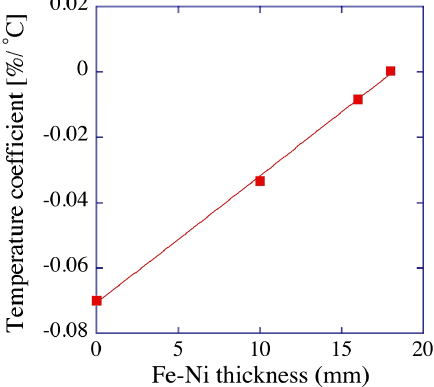
FIG. 5. Temperature coefficient versus shunt-alloy thickness. Squares are measured data. Solid line is a linearly fit to the measured data.